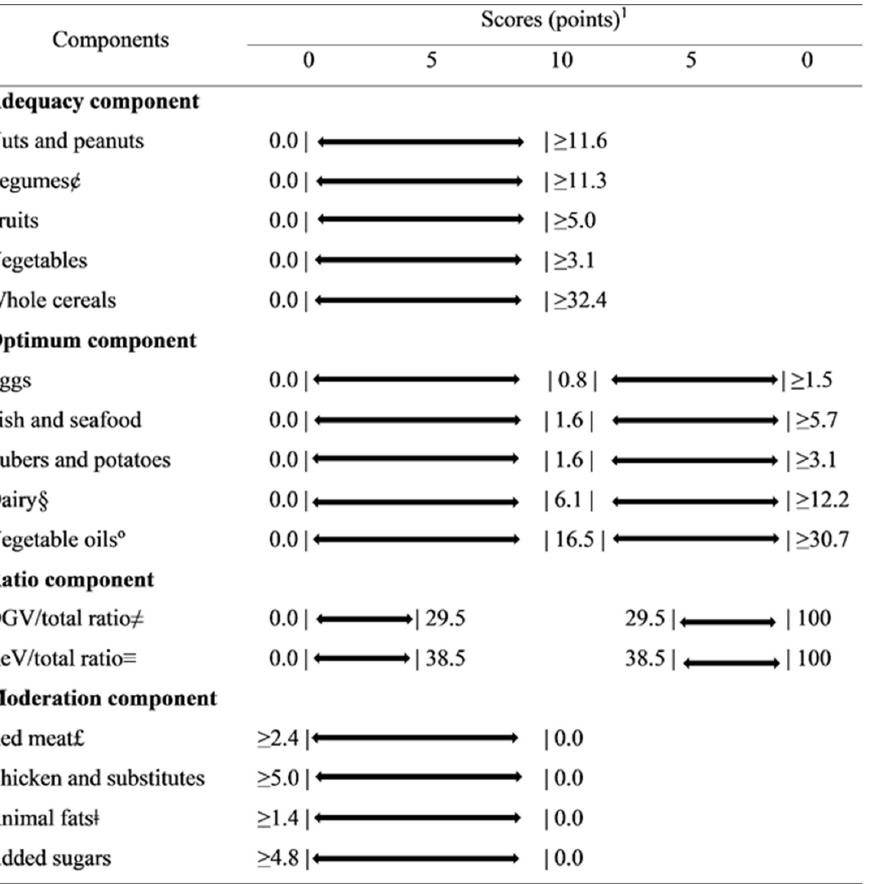
Figure 2. Planetary Health Diet Index components, standards for scoring (caloric densities) and corresponding points values. 1 All values expressed as caloric densities from the reference diet proposed by the EAT-Lancet Commission. The bars represent the limits. £ Red meat: beef, lamb and pork. ¢ Legumes: beans and soy. § Dairy: excluding dairy fats. ◦ Unsaturated oils: including palm oil. (cid:54) = DGV/total ratio: ratio between the energy intake of dark green vegetables (numerator) and the total of vegetables (denominator) multiplied by 10. ≡ ReV/total ratio: ratio between the energy intake of red and orange vegetables (numerator) and the total of vegetables (denominator) multiplied by 10. ‡Animal fat: lard, tallow and dairy fats. DGV/total ratio: dark green vegetable/total ratio. ReV/total ratio: red vegetable/total